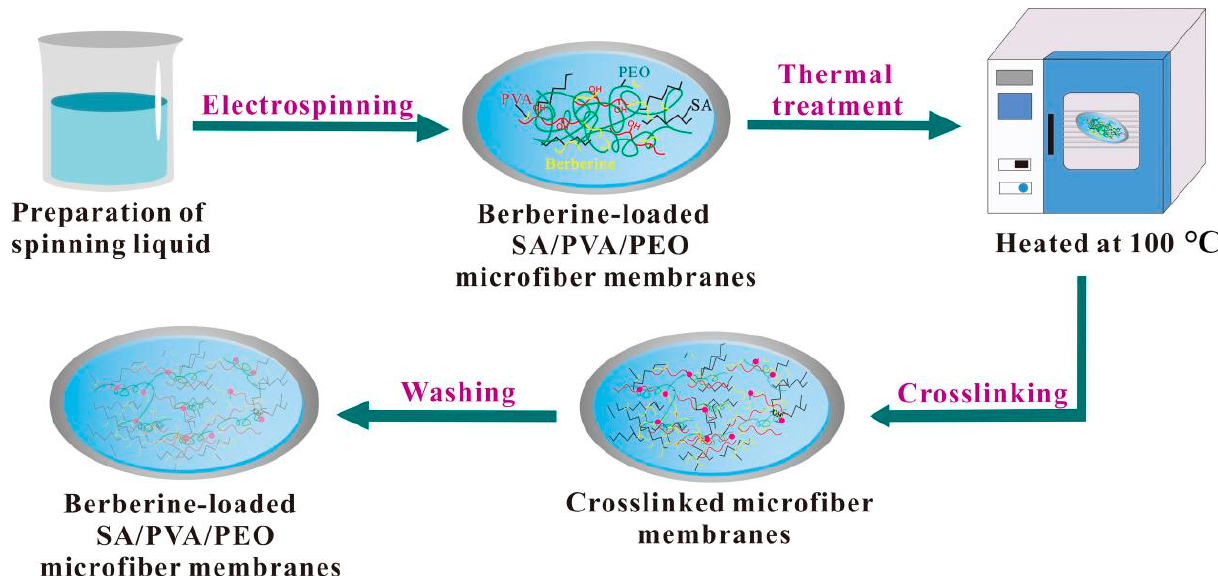
Figure 2. Preparation of berberine-loaded SA/PVA/PEO MFMs. Table 1. Thermal treatment of SA/PVA/PEO MFMs. The Ratio of SA/PVA/PEO Processing Temperature (°C)